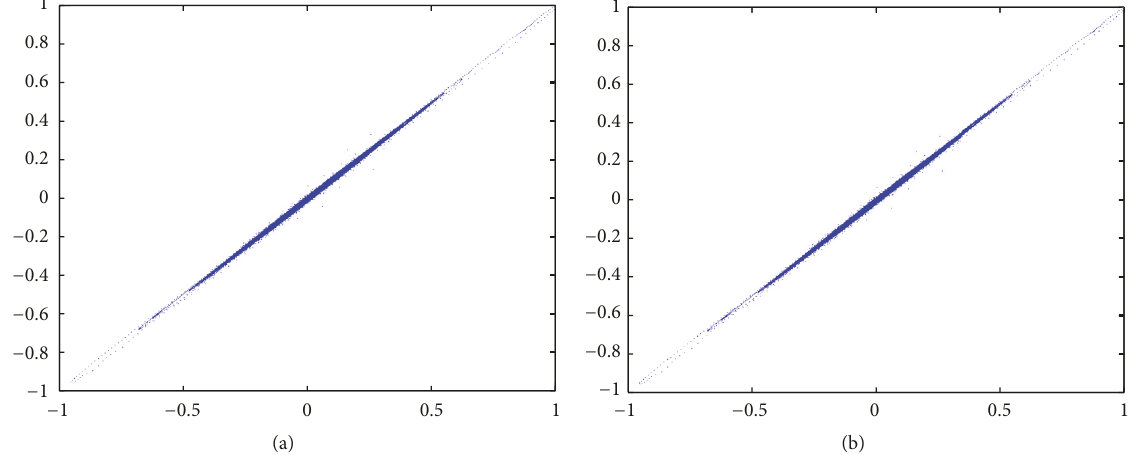
Figure 9: Original and embedded sound.